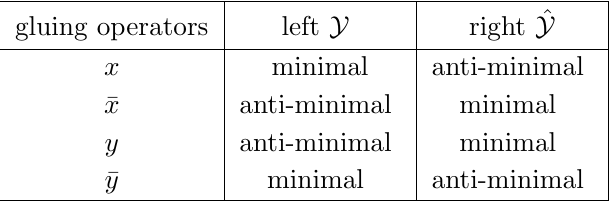
Table 1 . Transformation properties of gluing